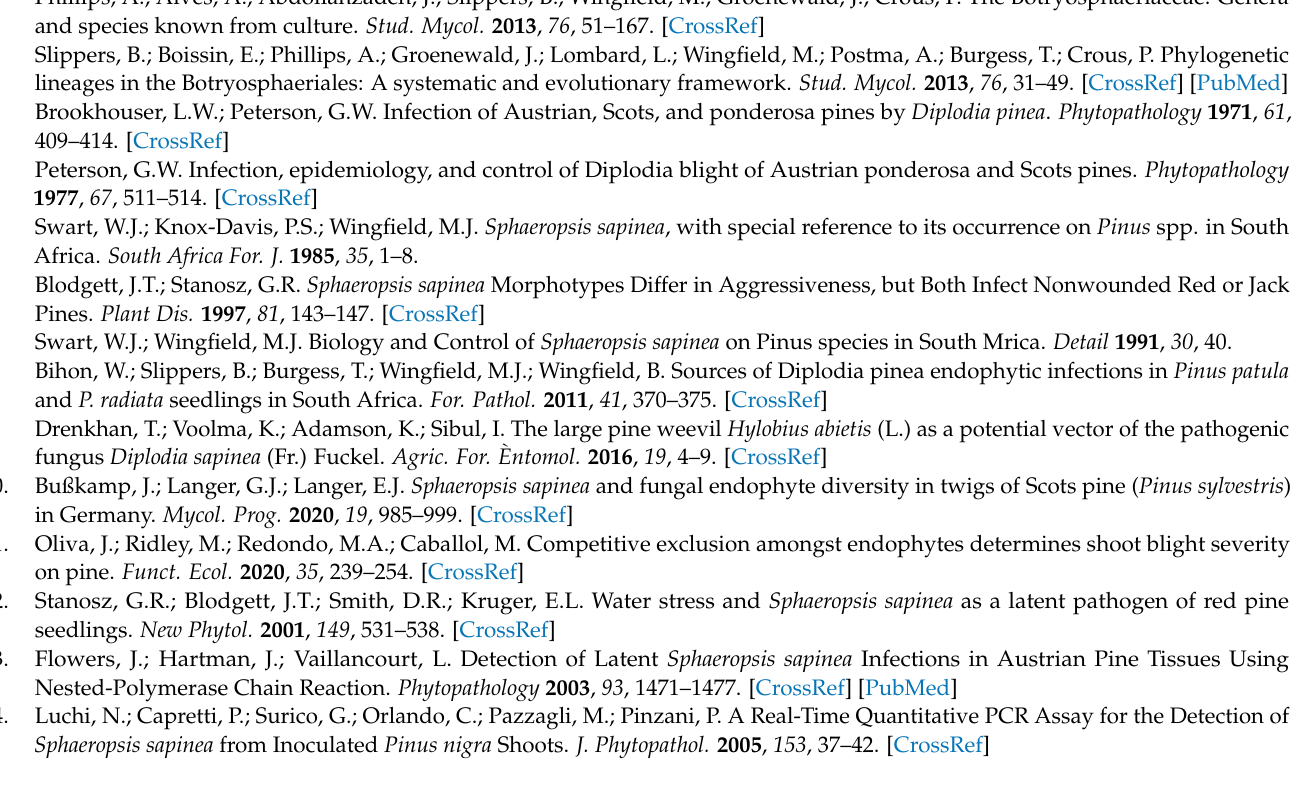
Diplodia sapinea isolates used in this study. Table S2: List of isolates used for D. sapinea specific primers validation. Table S3: Allele frequencies for 13 loci for D. sapinea